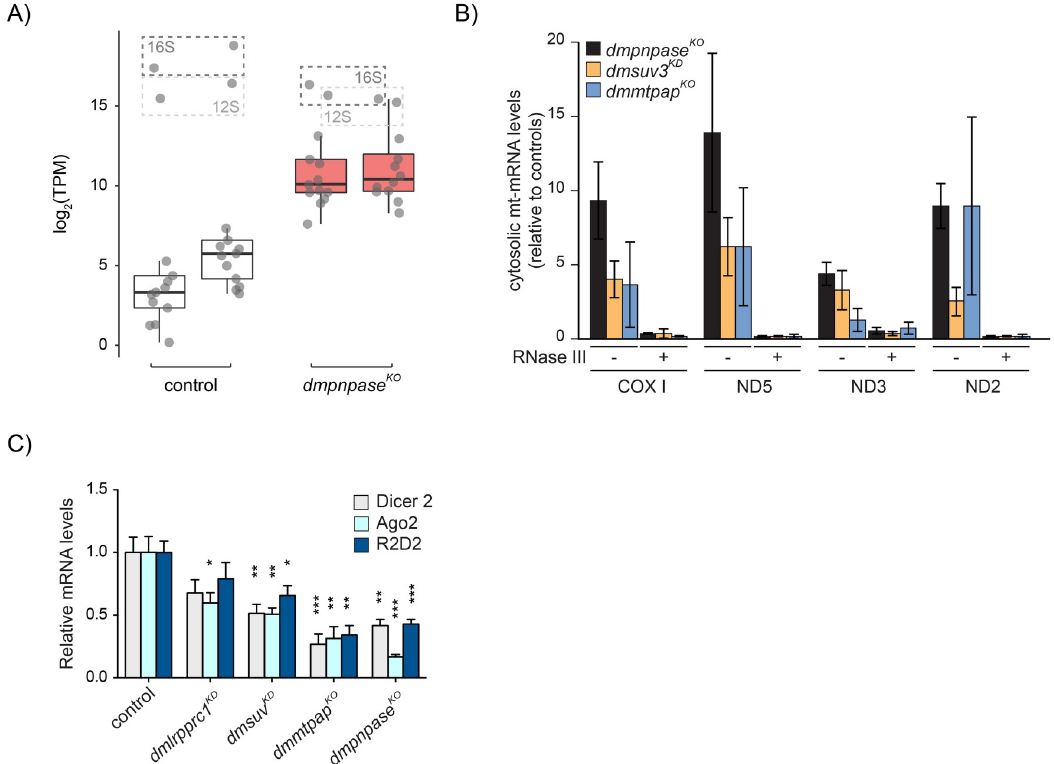
Fig 5. Cytoplasm-localised mitochondrial dsRNAs affect the cellular antiviral response pathways. ( A ) Boxplot showing normalised transcripts per million (TPM) values of double-stranded mitochondrial transcripts within the cytosolic fraction of control and dmpnpase KO fly models (n = 2). ( B ) qRT-PCR analysis of mtCOX1, mtND5, mtND3, and mtND2 in cytosol, fractionated from larvae of controls, dmpnpase KO , dmsuv3 KD , and dmmtpap KO and treated with RNase III. Data are represented as mean +/- SEM. ( C ) qRT-PCR analysis of Dicer2, Ago2, and R2D2 transcript levels in larvae of controls, dmlrpprc1 KD , dmpnpase KO , dmsuv3 KD , and dmmtpap KO . All data are represented as mean +/- SEM ( ��� p < 0.001, �� p < 0.01, � p < 0.05, n = 5 for dmlrpprc1 KD , dmpnpase KO , and dmsuv3 KD . n = 3 for dmmtpap KO ).